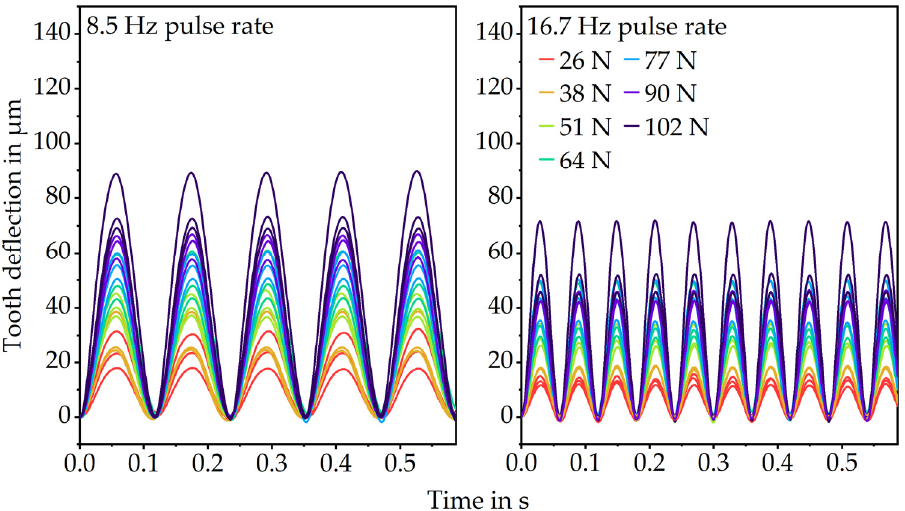
Figure 6. Results for the elastic tooth bending (pulsator tests).